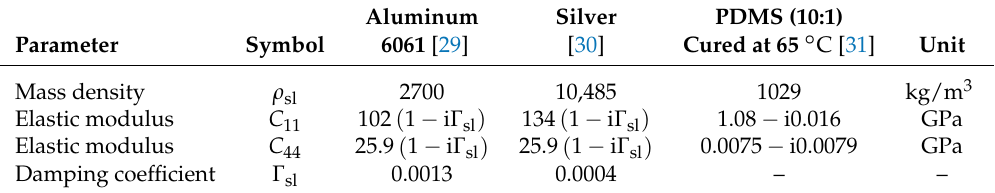
– – (cid:1) (cid:0) ρ pa − 1 2 ρ fl and f 1 = κ fl + 1 2 ρ pa ρ fl